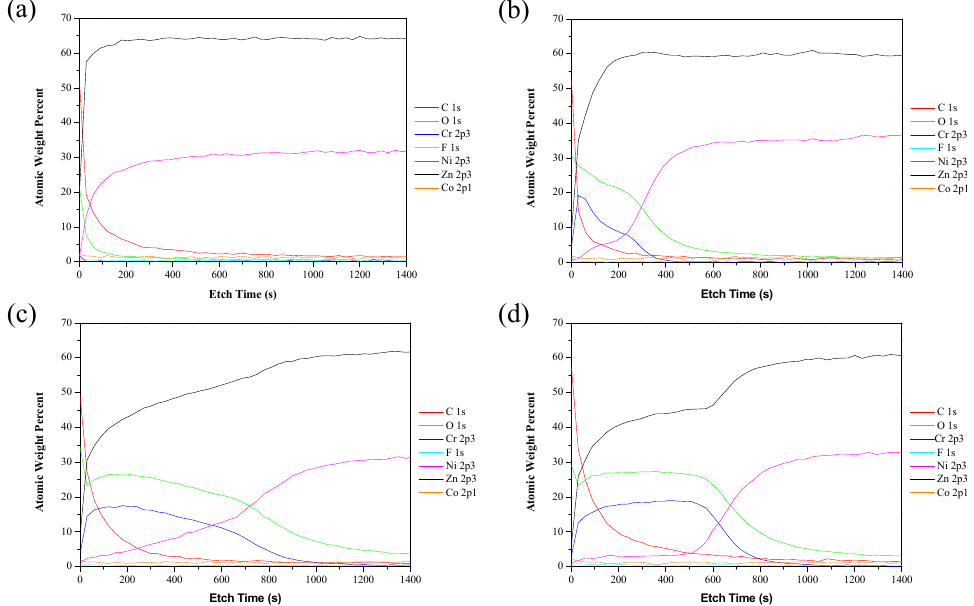
Figure 11. XPS depth profiles of Zn, Ni, Cr, Co, O, F, and C in Zn–Ni alloy trivalent chromium coatings by Ar ion etching. ( a ) Zn–Ni Alloy coatings, ( b ) NaF 0% 60 s chromium conversion treatment, ( c ) NaF 50% 60 s chromium conversion treatment, and ( d ) NaF 100% 60 s chromium conversion treatment.